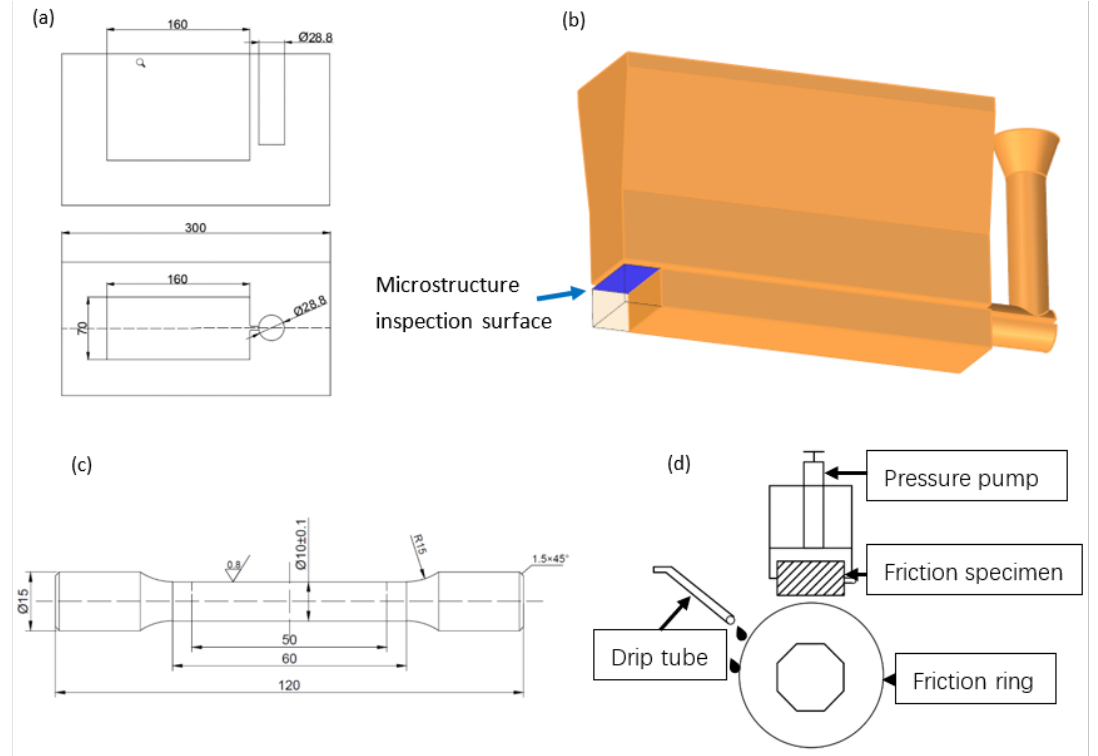
Figure 1. Schematic illustration of the ( a ) mold for casting, ( b ) cast specimen showing position for microstructure analysis, ( c ) tensile test specimen and ( d ) the contact mode of the friction pair.